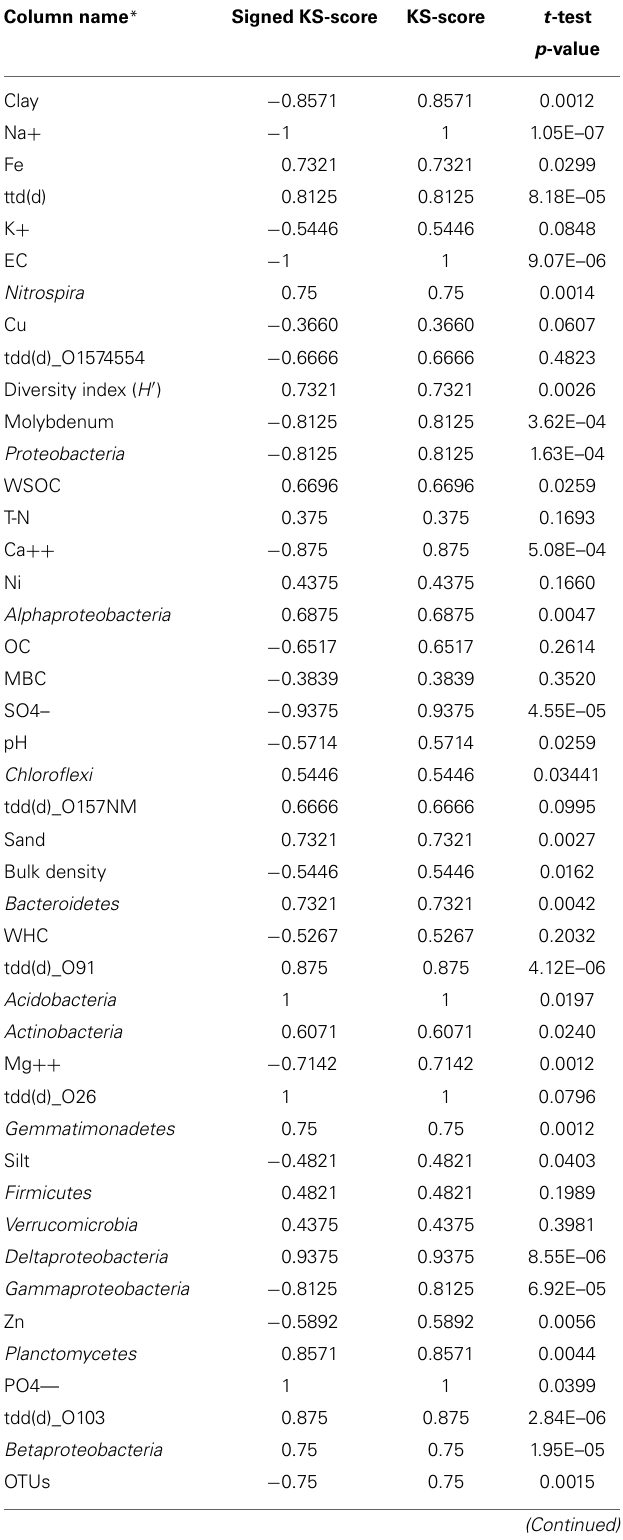
Table 2 | Kolmogorov-Smirnov test and t -test to identify soil and biological properties that best differentiate between Salinas Valley and Imperial/Yuma Valley